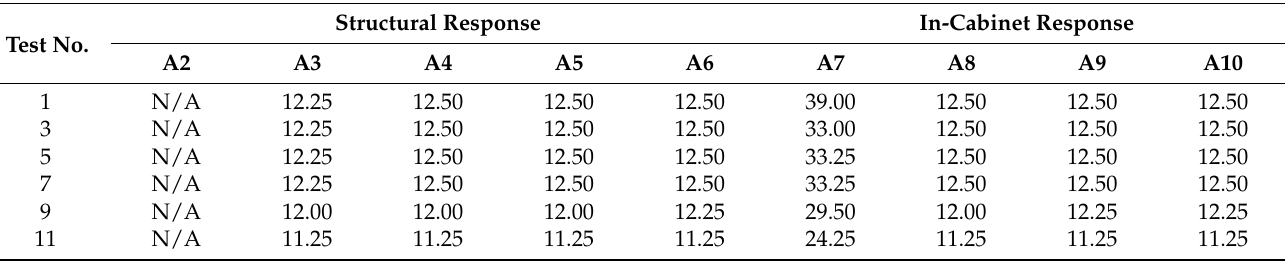
Table 3. Summary of side-to-side resonant-frequency test.